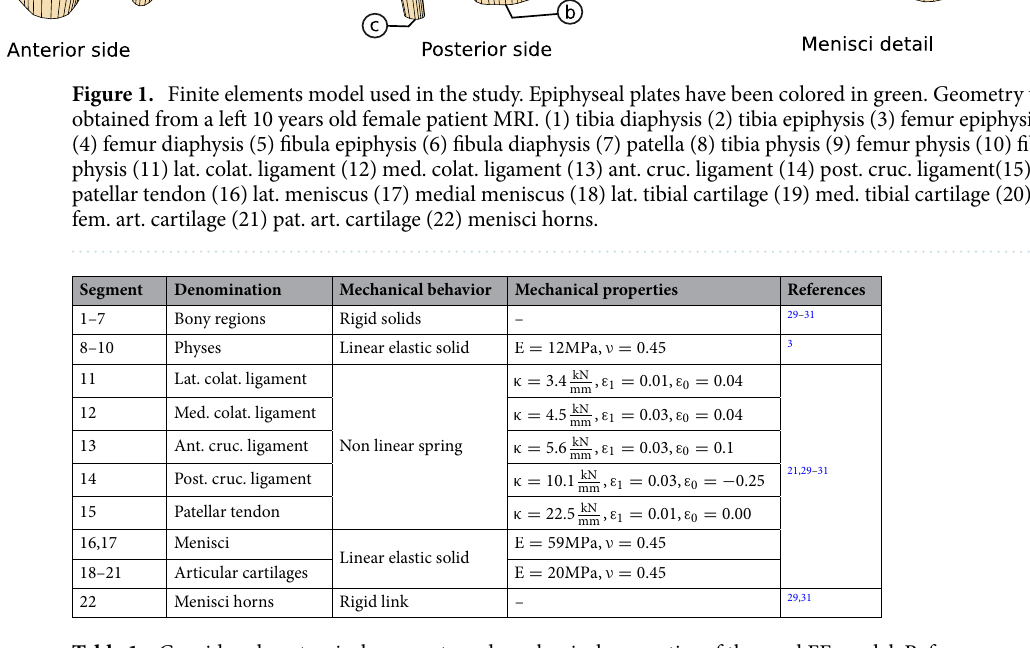
Table 1. Considered anatomical segments and mechanical properties of the used FE model. Reference numbers as detailed in Fig.